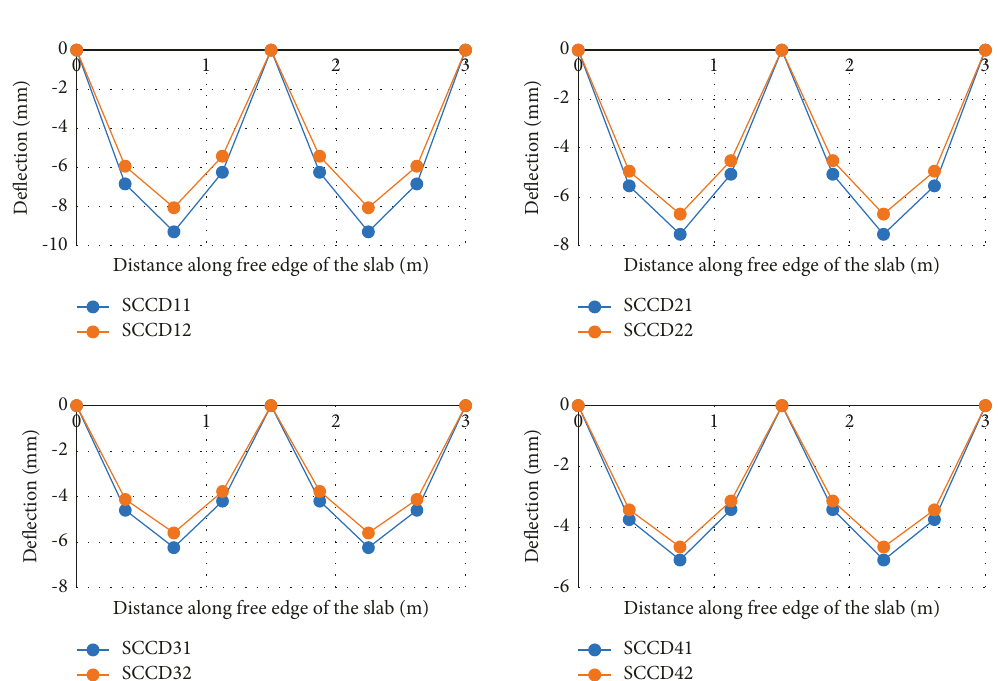
Figure 14: Effect of drop panel on slab